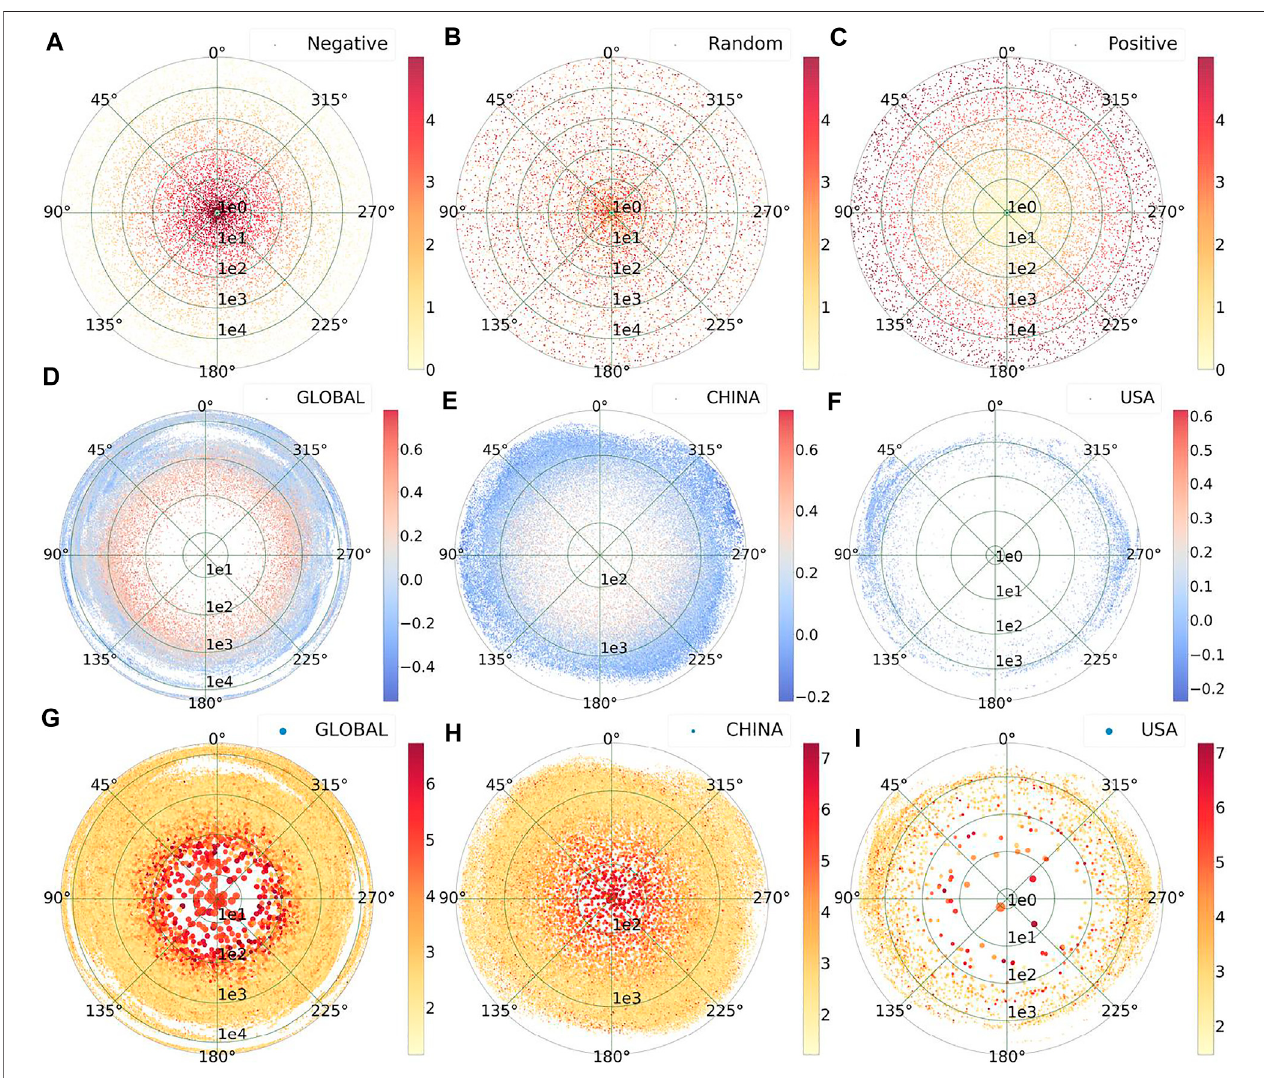
FIGURE3| Thecorrelationsandpolarcoordinatesfor PM 2 . 5 crosscorrelationsglobally,inChina,andintheUSA. (A) showsthatcrosscorrelationsdecreasedwith distance, regardless of direction; correlation strength is represented by the color of the bar. (B) shows the cross correlation distributions for the random time series; a random relationship waspresent between cross correlationand distance. (C) shows thatcross-correlationsincreased withdistance, regardless of direction; correlation strengthisrepresentedbythecolorofthebar. (D – F) showPearson ’ scorrelationcoef fi cient ρ forallpossiblenodalpairsworldwide,inChina,andtheUnitedStates, respectively; distance is plotted on a logarithmic scale. Finally, (G – I) show the cross correlation W max for all possible nodal pairs worldwide, in China, and in the United States, respectively. Angles indicate directions between pairs of nodes, and radii indicate distances between pairs of nodes on a logarithmic scale. Dot colors show relationship